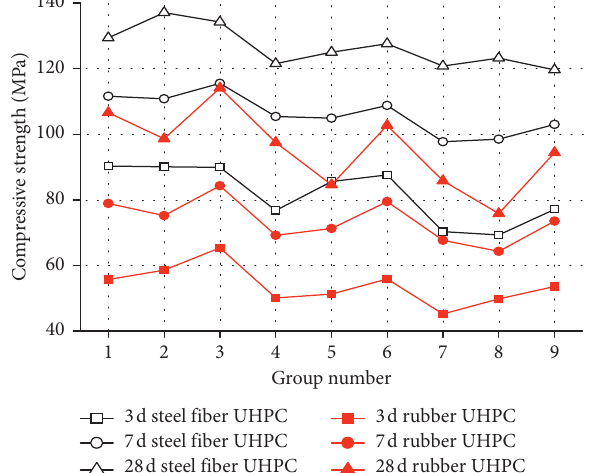
Figure 3: Compressive strength of steel fiber UHPC and rubber